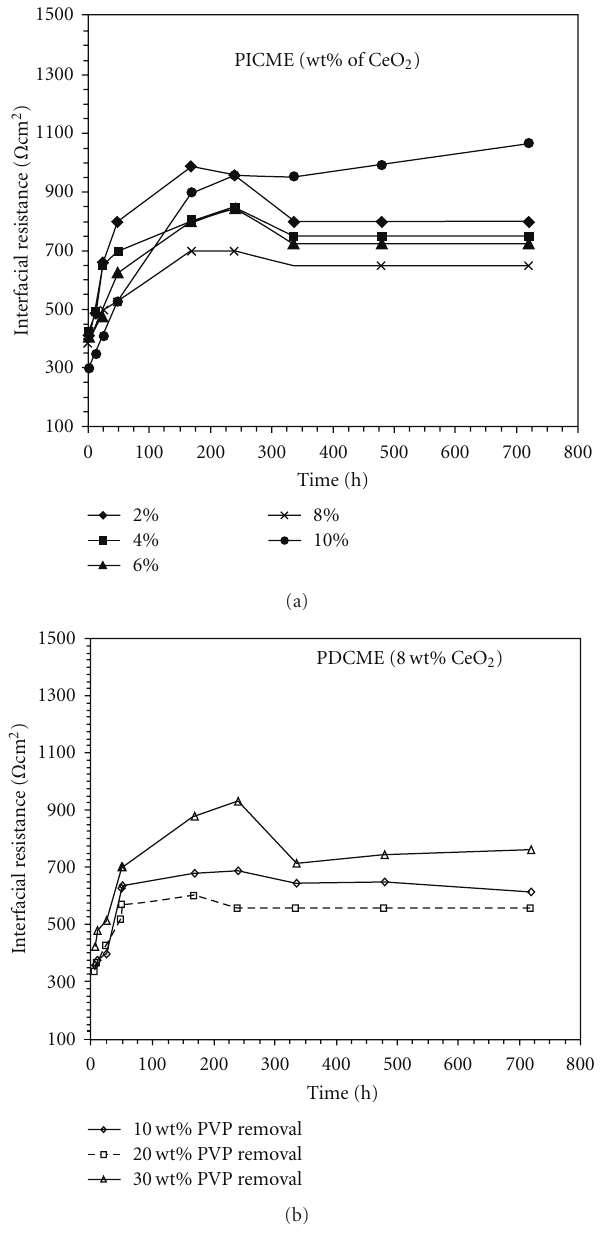
Figure 6: Interfacial resistance of the composite microporous membrane electrolyte (a) PICME and (b) PDCME.